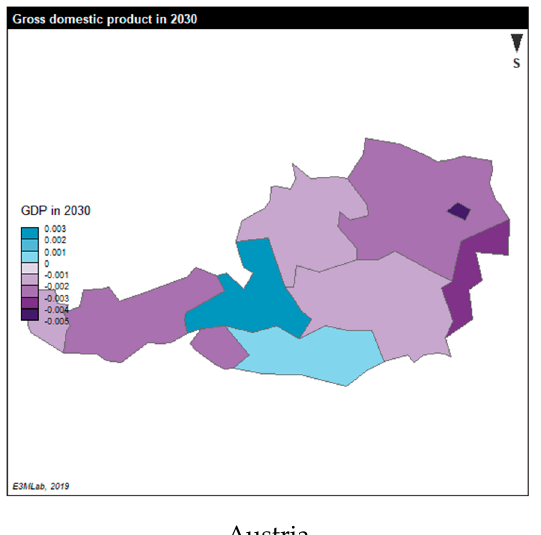
Figure 3. Percentage change of regional GDP to the base case in 2030.